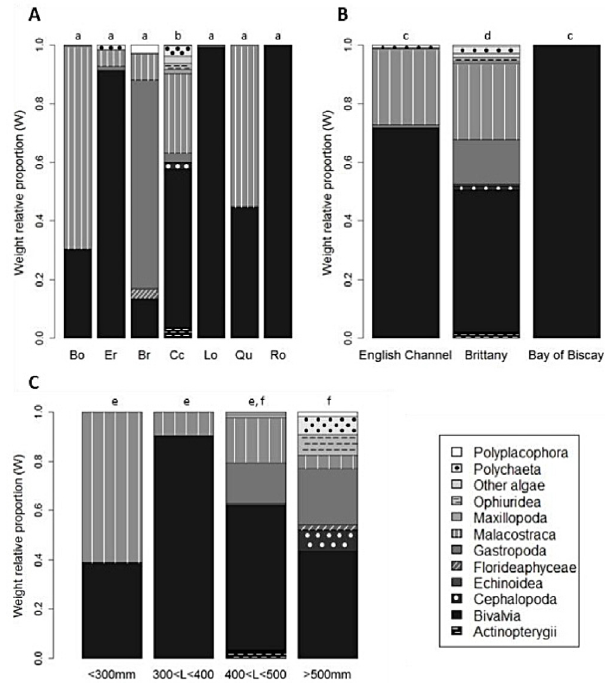
Fig. 4. Diet composition of the gilthead seabream expressed in weight relative proportion (W) by sites (A), latitudinal position (B) and size categories of predator (C). On each graph, di ff erent lowercase letters above bars indicate significant di ff erences according to the post-hoc analysis for the Friedman test ( p < 0 . 05). N.b.: site abbreviations: see legend Figure